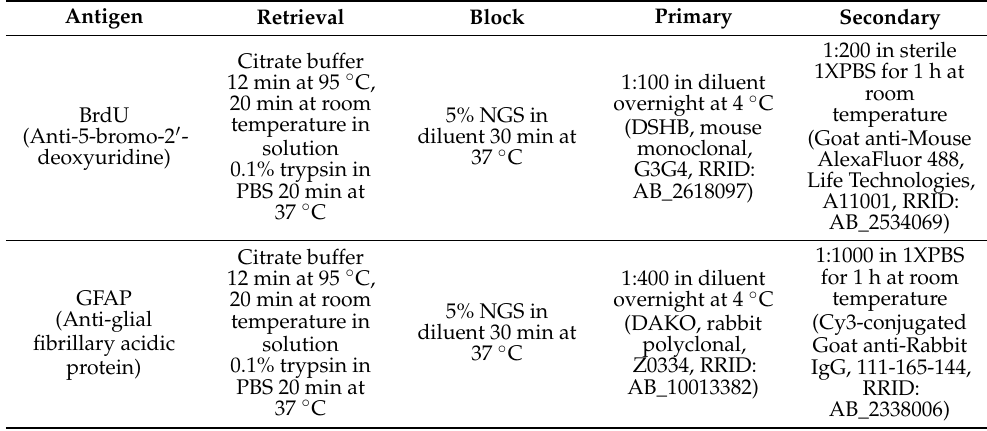
Table 1. Summary table of optimized immunofluorescent protocols for proteins of